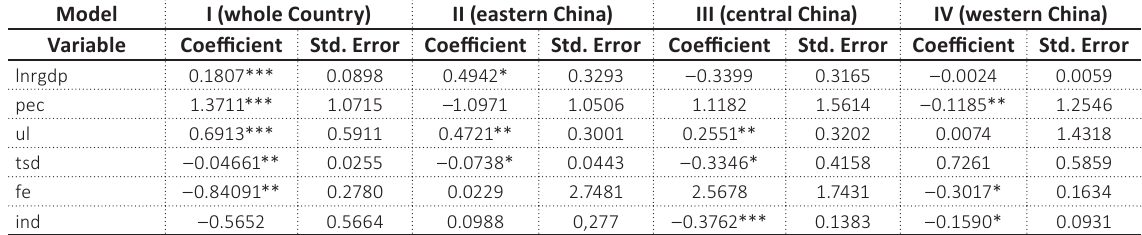
Table 4. The influence factors of GFHE performance in the whole country and the eastern, central, and western